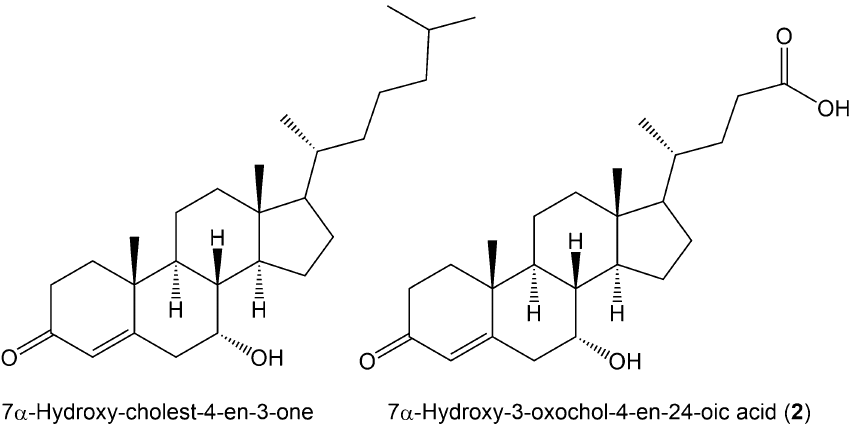
Figure 1. 7α-Hydroxy-cholest-4-en-3-one formed from 7α-hydroxycholesterol in the neutral bile acid synthesis pathway and 7α-hydroxy-3-oxochol-4-en-24-oic acid ( 2 ) formed in the acidic bile acid synthesis